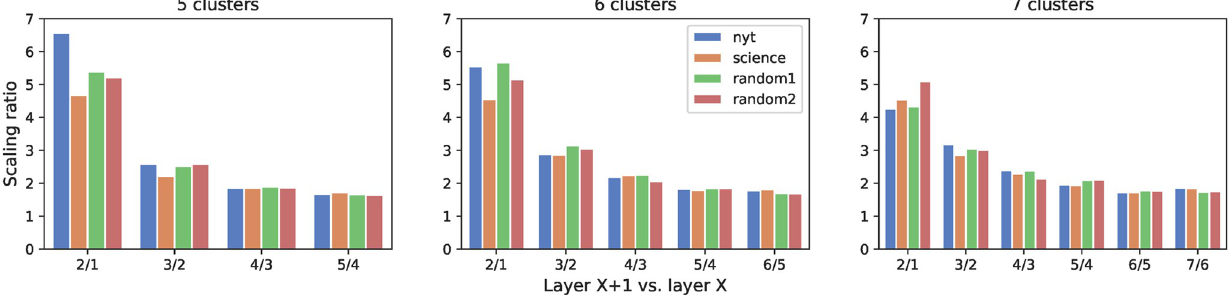
Fig 6. Scaling ratio. Each panel captures egos with a different optimal number of clusters. Error bars correspond to the 95% confidence intervals.